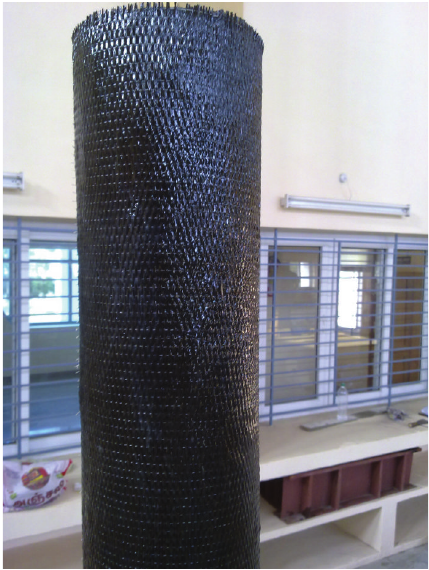
Figure 2: Orientation of fibre for flexural and tension warp in vertical